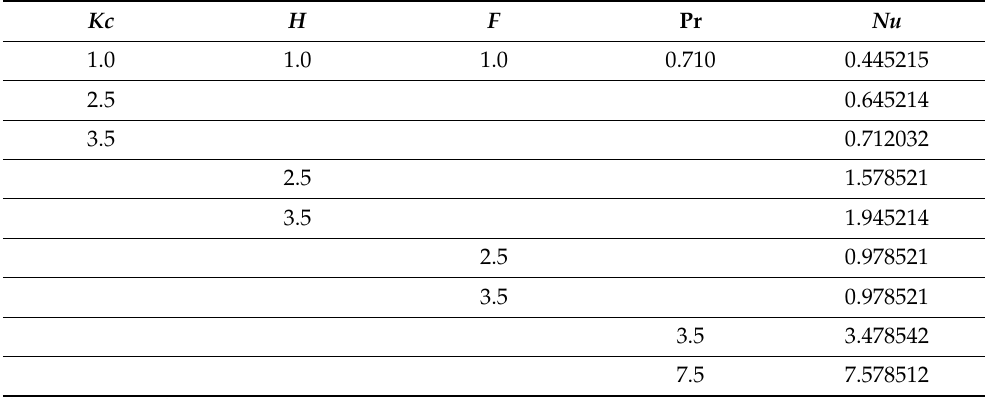
Table 2. The Nusselt number ( Nu ).